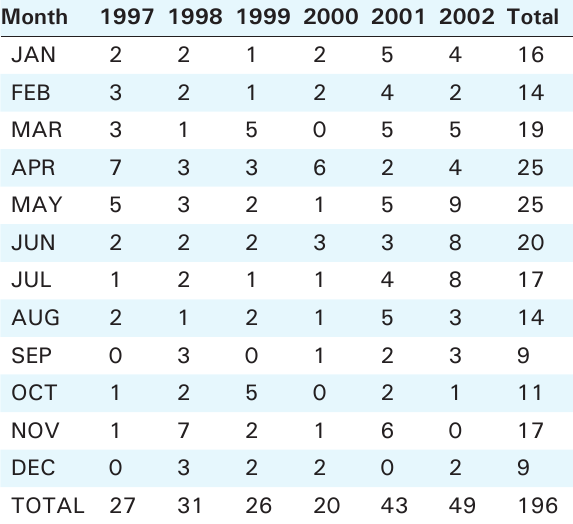
table 6. Monthwise Distribution Of Leukemia Month